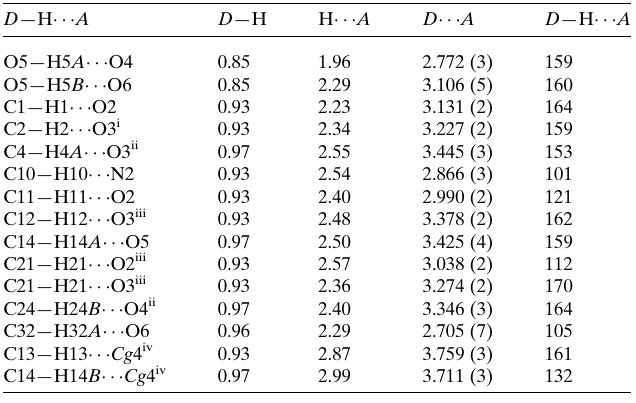
Table 1 Hydrogen-bond geometry (A˚ , (cid:3)